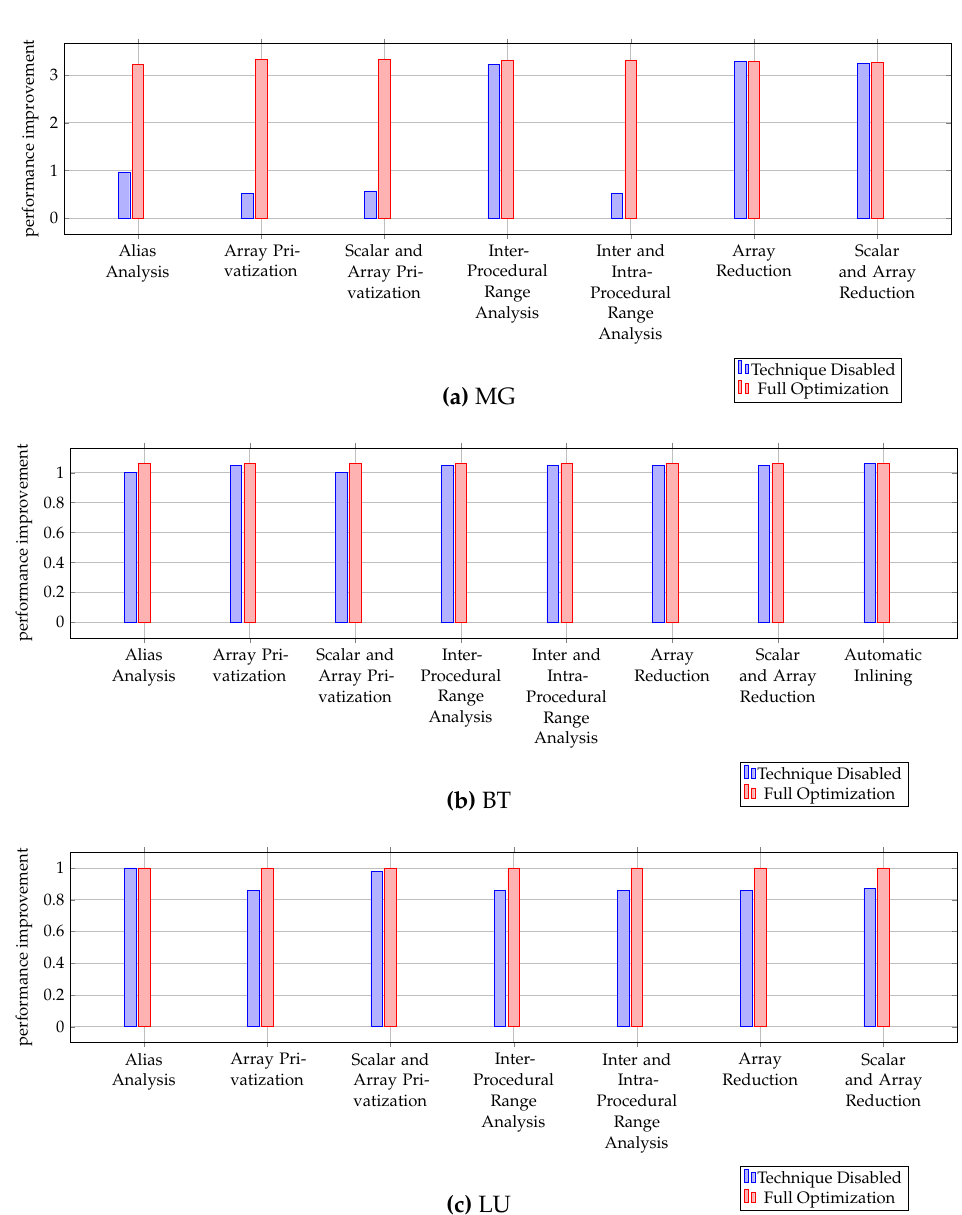
Figure 5. Performance results for MG, BT and LU benchmarks from the NAS Parallel benchmark suite v3.3 for input class B. The selected base case is the best tuned version (all on). One technique at a time is turned OFF and the impact on performance is plotted (Lower bar means a higher impact of the